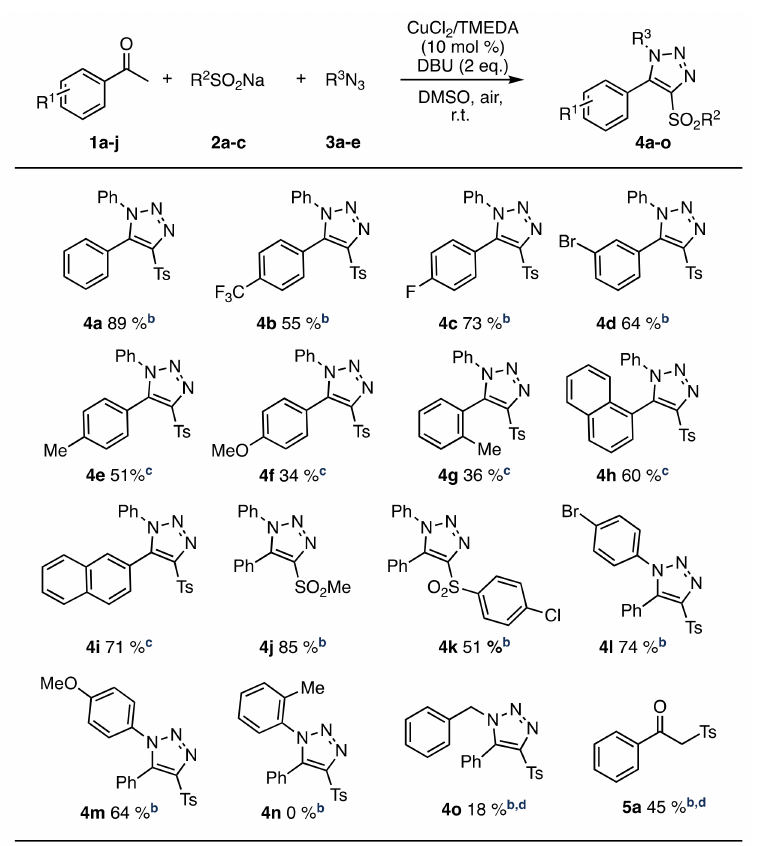
Scheme 2. Substrate scope for three-component 4-sulfonyl triazole synthesis . a Reaction